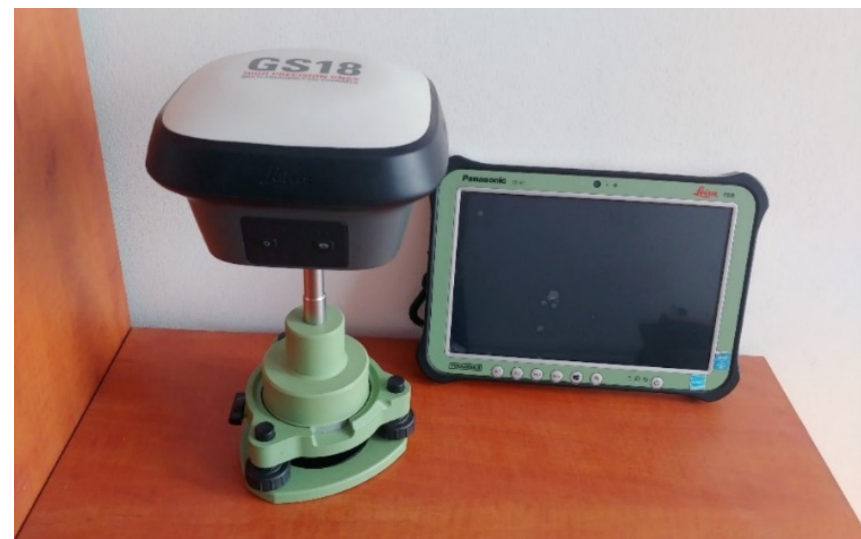
Figure 3. Leica GS18T receiver with Leica CS35 controller.